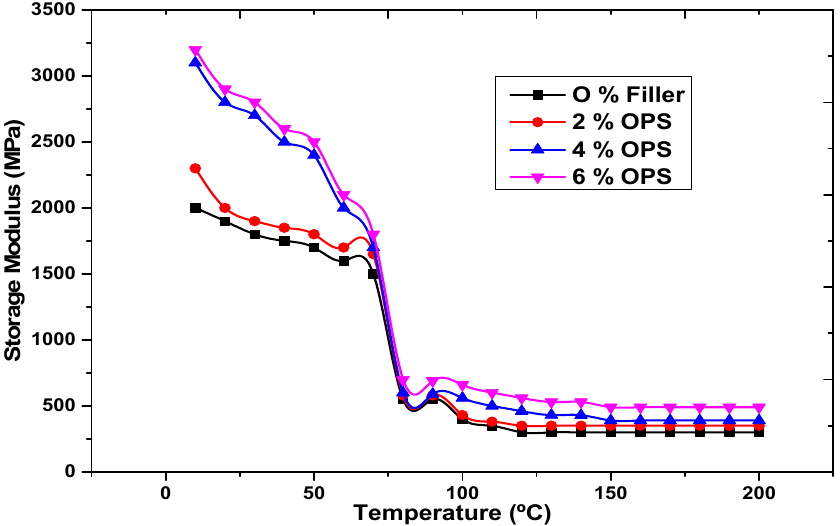
Figure 8. Effectiveness of the OPS nanofiller content on the flax/epoxy-based hybrid composites on the storage modulus.